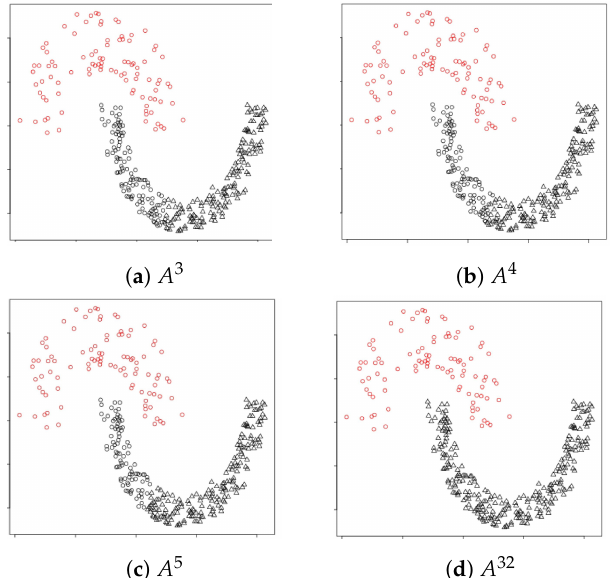
Figure 1. Identifying clusters in Jain dataset using PAM clustering algorithm as we apply the transformation discussed in Section 5